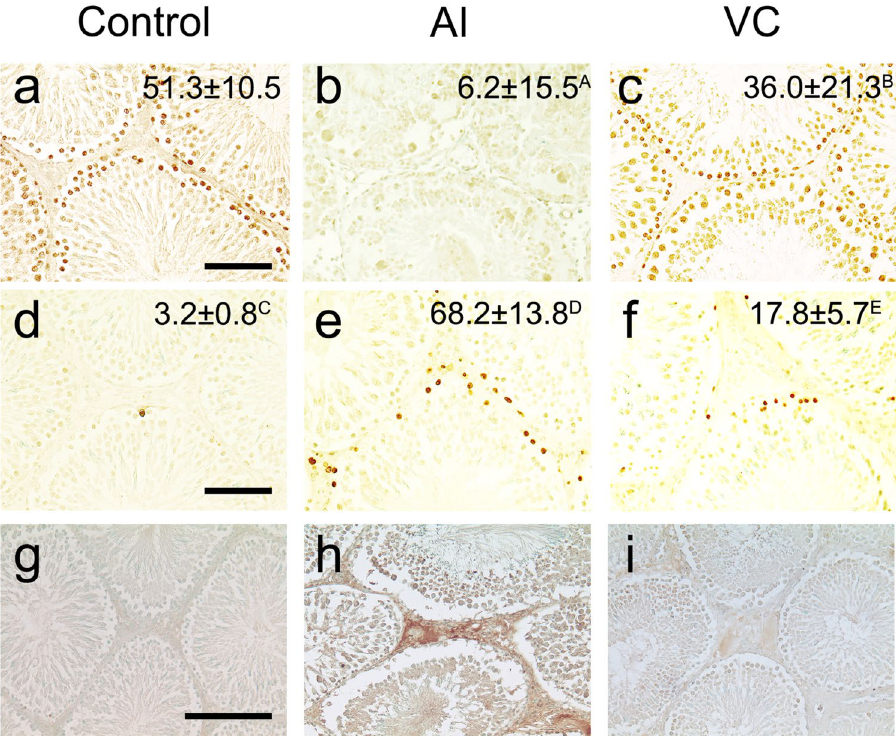
Figure 3. Proliferating cell nuclear antigen-positive cells ( a – c ), Tdt-mediated dUTP nick end labelling- positive cells ( d – f ) and 8-hydroxydeoxyguanosine ( g – i ) in the sections of rat testes with arterial ischaemia (AI) and venous congestion (VC) at 6 h. ( a , d and g) Control group. ( b , e and h ) AI group. ( c , f and i ) VC group. Bar = 50 μ m.